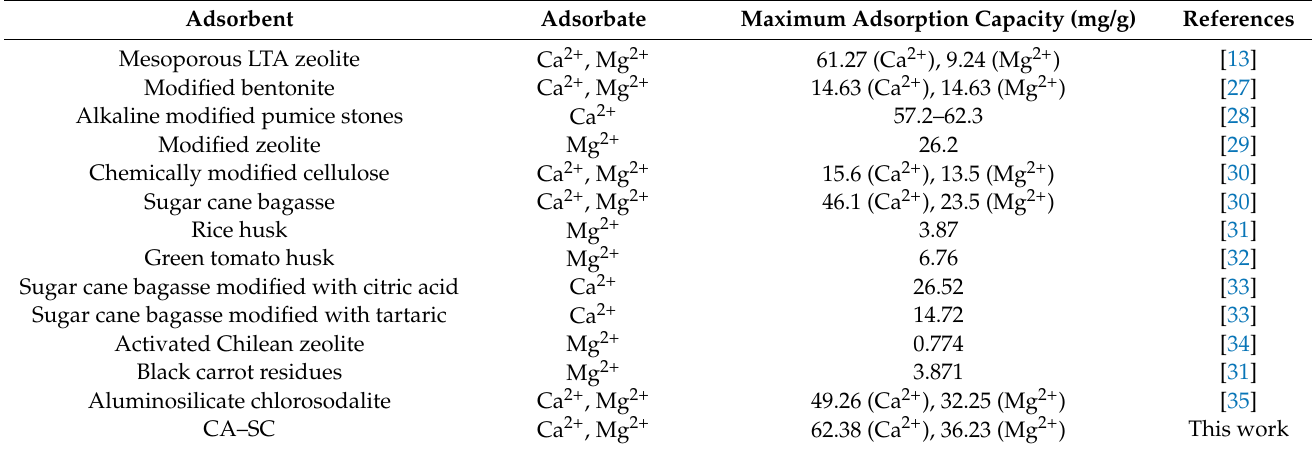
Figure 7. Maximum adsorption capacity of CA–SC for Ca 2+ and Mg 2+ . Table 3. Adsorption capacities of the reported adsorbents for Ca 2+ and Mg 2+